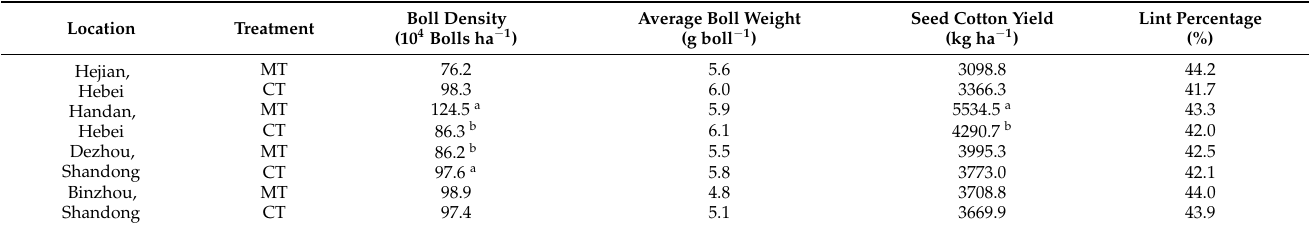
Table 2. Effect of manual (MT) and chemical topping (CT) on seed cotton yield and yield components in 2018